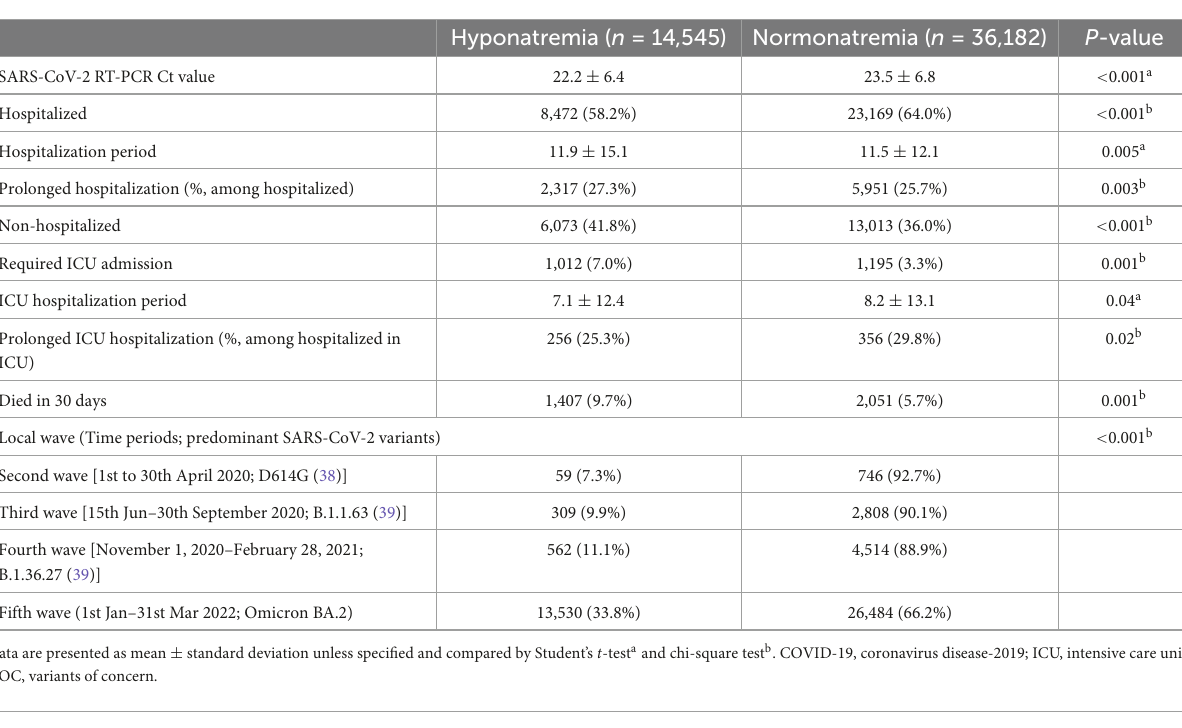
but this was not statistically significant after adjusting for gender, age and other biochemical parameters. A similar percentage of SARS patients requiring ICU care presented with hyponatremia compared to other SARS patients (42.3 vs. 43.2%, P =